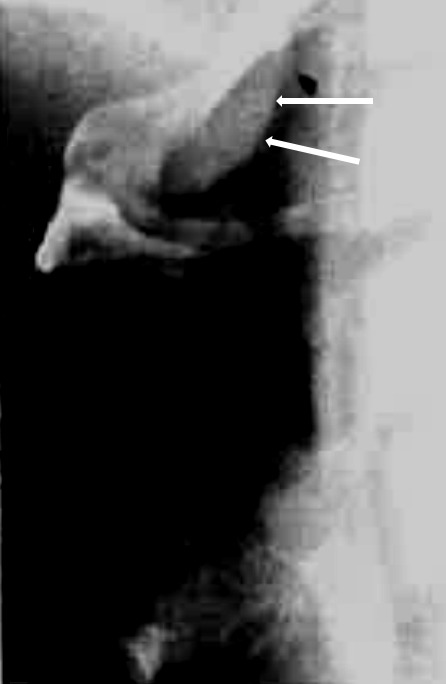
Missing laryngeal elevation during the swallowing act in Eagle syndrome. The arrows indicate the epiglottis.